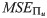
Biot’s equations—forward modeling: mean square training error plot.This model uses Nhl = 6, Nn = 20, Nb = 96, and NΠ = 160. MSE, MSEb, MSEΠu, and MSEΠp are calculated using Eqs 44, 45, 46, and 47, respectively.